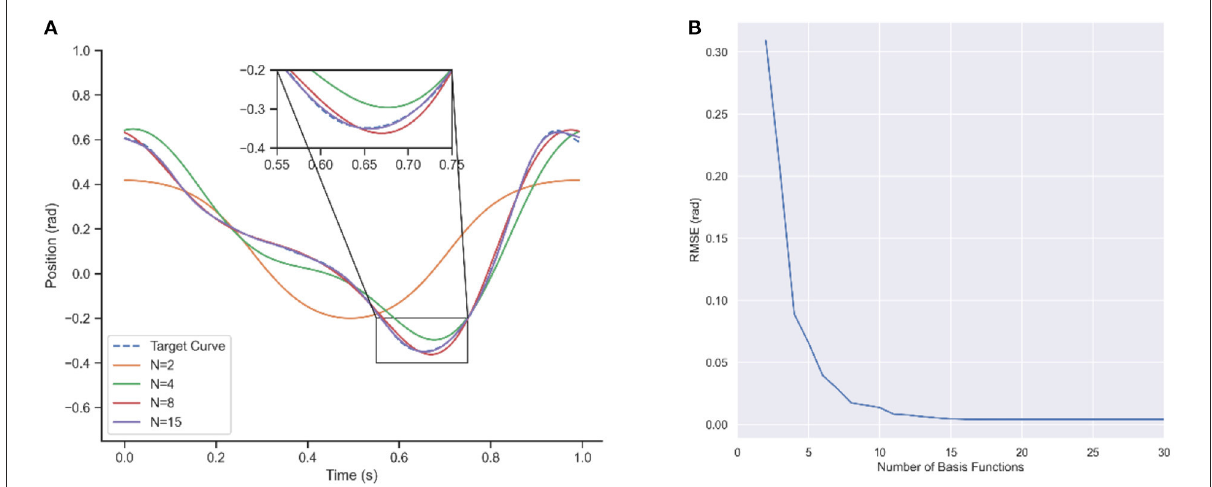
FIGURE5 Trajectory learning results for different number of basis functions. (A) Curve after Learning. (B) RMSE of learning.